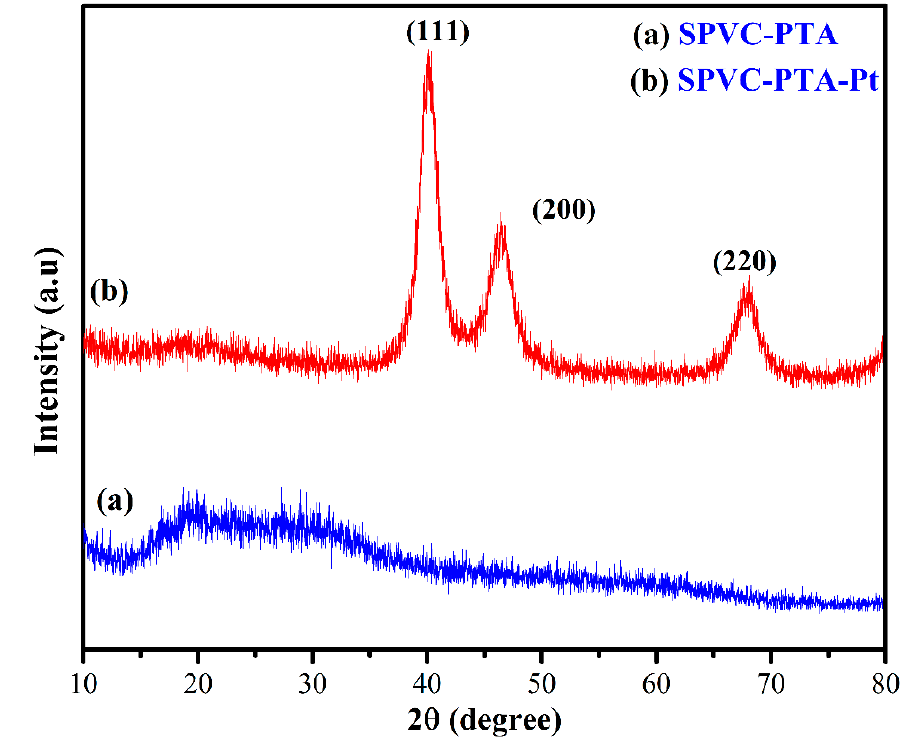
Figure 8. XRD spectra of the ( a ) SPVC–PTA and ( b ) SPVC–PTA–Pt IPMC membranes.